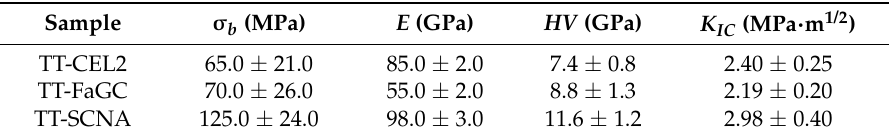
Table 4. Mechanical properties of the sintered